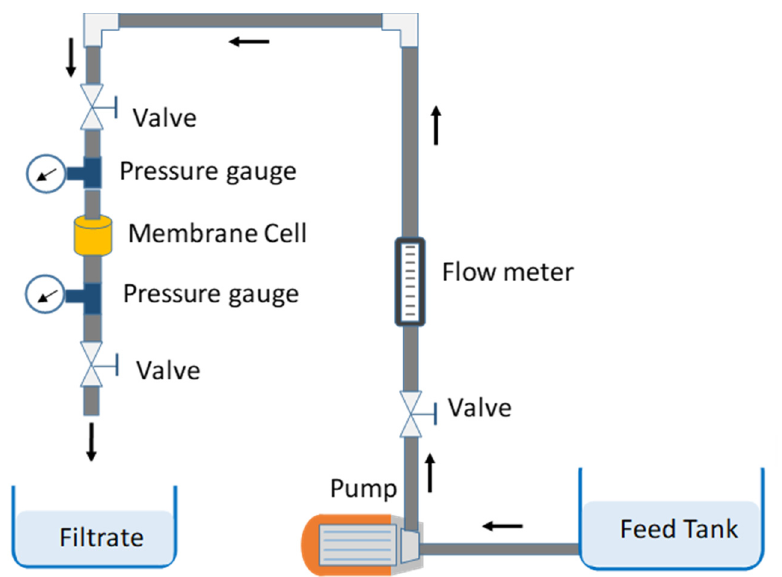
Figure 2. Schematic diagram of the flow loop module